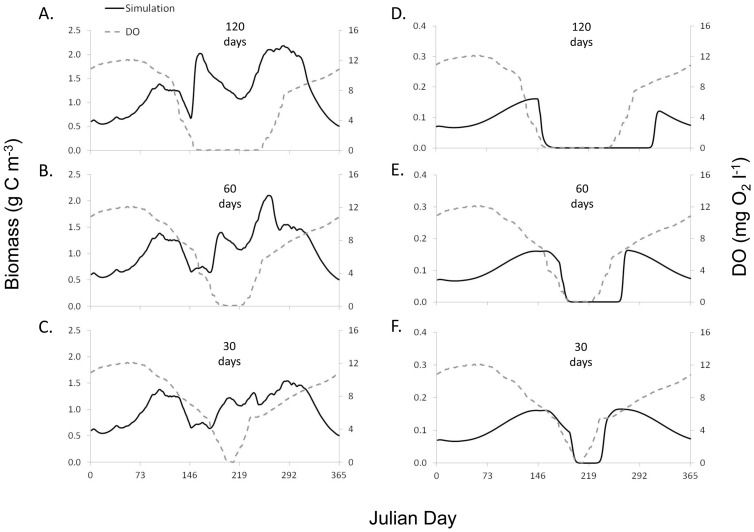
Simulations of hypoxic duration and phyto- and zooplankton response.Simulated phytoplankton biomass under hypoxic durations of (A) 120, (B) 60, and (C) 30 day, and zooplankton biomass under hypoxic durations of (D) 120, (E) 60, and (F) 30 days. Left y-axis: the gray solid line represents modeled biomass and the black dots denote mean observed biomass from site LE3.6 of the Chesapeake Bay Water Quality Monitoring Program from 1985–2001. Right y-axis: the grey dashed line indicates the dissolved oxygen concentration on the right y-axis. Modeled phytoplankton and zooplankton biomass responded inversely to hypoxic simulations.